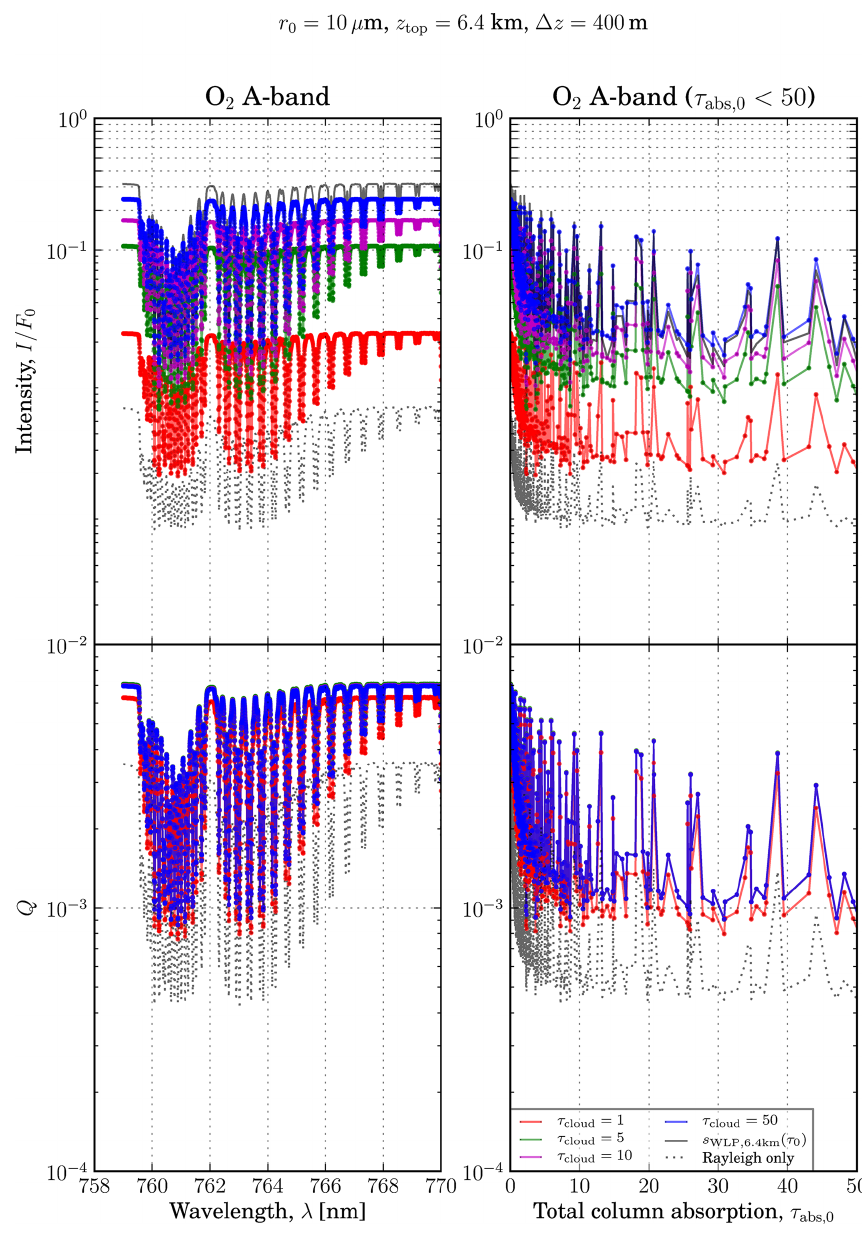
Figure 5. Intensity (top) and degree of polarization (bottom) due to a cloud-laden atmosphere of constant cloud droplet size, r 0 = 10µm, at a top height of z top = 10 . 4km but varying cloud optical thickness τ cloud in the O 2 A